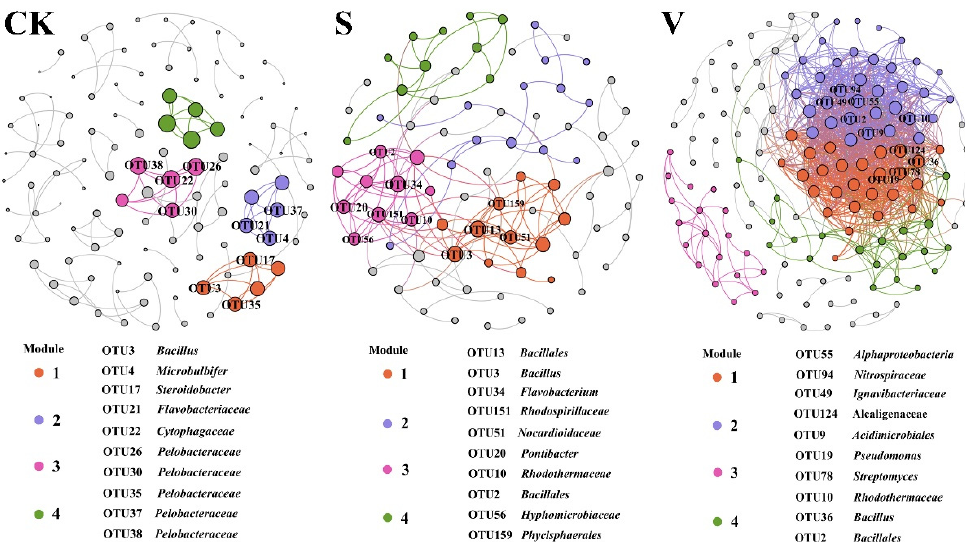
Figure 3. Co-occurrence networks of bacterial core microbiomes in soils under different treatments. Control group (CK); sludge treatment (S); vermicompost treatment (V). Keystone taxa, defined by the core OTUs with top 10 degrees, are labeled in black. Table 2. Topological properties of bacterial co-occurrence network.